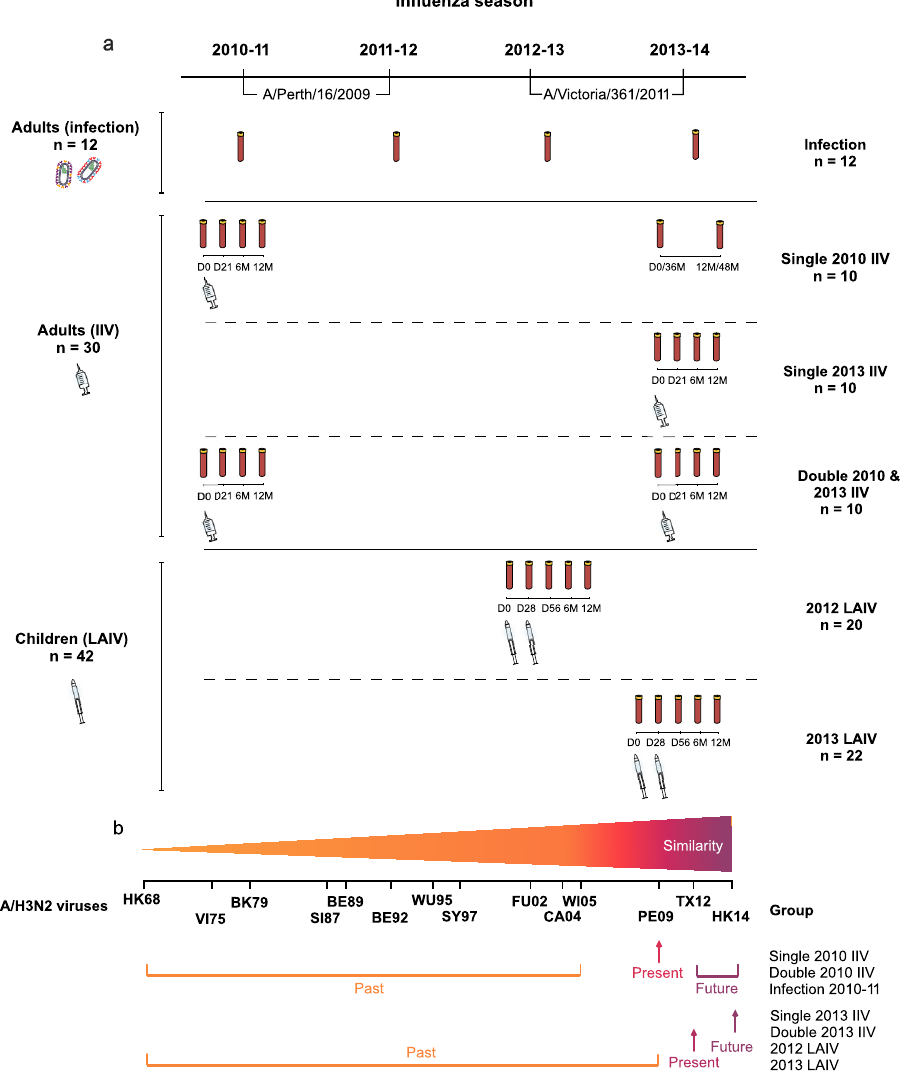
Fig. 1 Study design. During the in fl uenza seasons 2010-14, the A/H3N2 component in the seasonal vaccine changed from A/Perth/16/2009 in 2010-12 seasons to A/Victoria/361/2011 in 2012-14 seasons. a A group of unvaccinated adults were infected with circulating in fl uenza A/H3N2 viruses, de fi ned as a fourfold seroconversion in HI titres between pre- and post-season blood samples (infection, n = 12). Thirty adults were vaccinated with IIV during the study period, generating three different vaccination groups ( n = 10 each): single 2010 IIV, single 2013 IIV and double 2010 and 2013 IIV. Five individuals from the single 2010 IIV group provided long-term follow-up blood samples 36 and 48 months after vaccination (equivalent to day 0 and 12 months in the 2013-14 season). The children ’ s cohort were vaccinated with either one ( ≥ 9 years old) or two doses (<9 years old) of a live-attenuated in fl uenza vaccine (LAIV) in two different in fl uenza seasons (2012 LAIV ( n = 20) and 2013 LAIV ( n = 22)). Blood samples were collected in all vaccinated individuals at day 0 (D0) and post-vaccination day 21/28 (D21/D28), day 56 (D56, only in children), 6 and 12 months (6 M, 12 M). (b) Timeline of A/H3N2 viruses circulated from 1968 to 2018 and the different groups ’ perspective of past, present and future viruses according to the timeline. Adults vaccinated or infected in 2010-12 with the A/Perth/16/2009 (PE09) had not yet been exposed to A/Texas/50/2012 (TX12) or A/HongKong/4801/2014 (HK14), de fi ned as future strains for these subjects. Vaccinated or infected adults, and vaccinated children, in 2012-14 had not been exposed to the future strain HK14 which circulated from